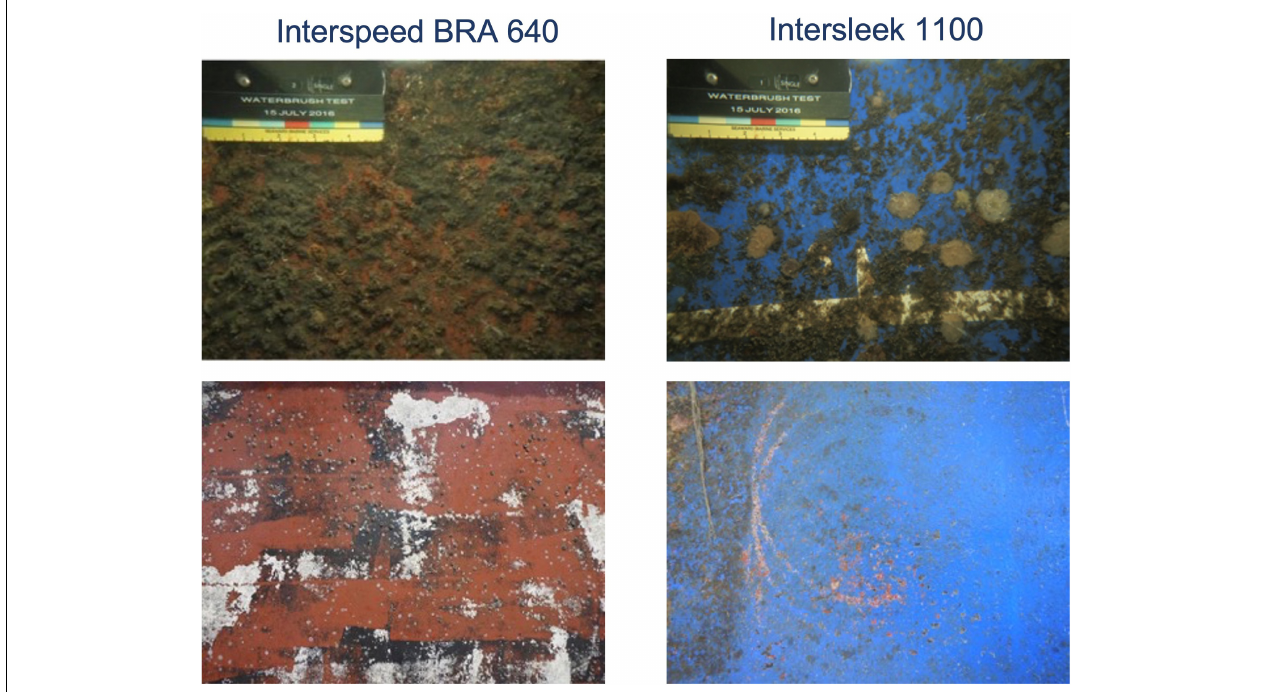
FIGURE 10 | The impact of underwater cleaning using a handheld polypropylene or wire brush.